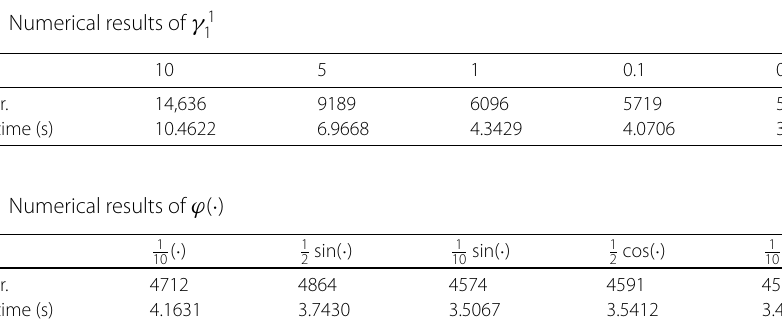
Table 2 Numerical results of γ 1